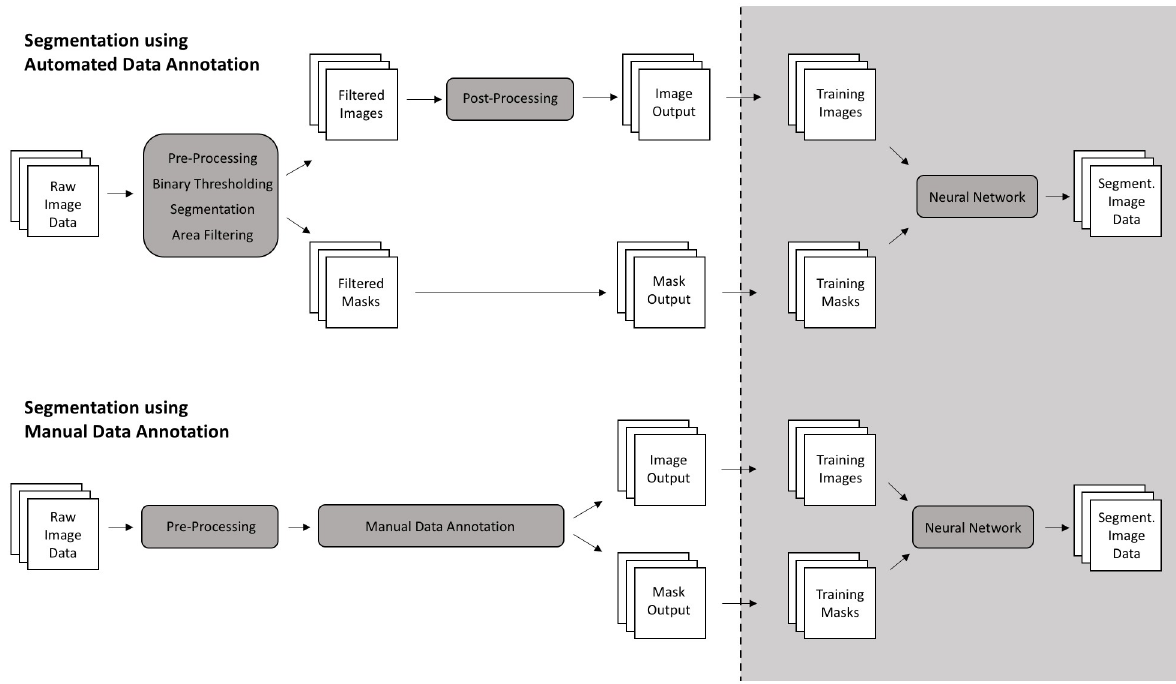
Fig 2. Process of automated and manual nuclei annotation for segmentation with a neural network. Automated data annotation considers image pre-processing, binary thresholding, watershed-segmentation, filtering and post-processing to provide a training dataset for nuclei segmentation with a neural network. Manual data annotation is applied on raw image data (after pre-processing) in order to provide a training dataset of images and annotation masks.